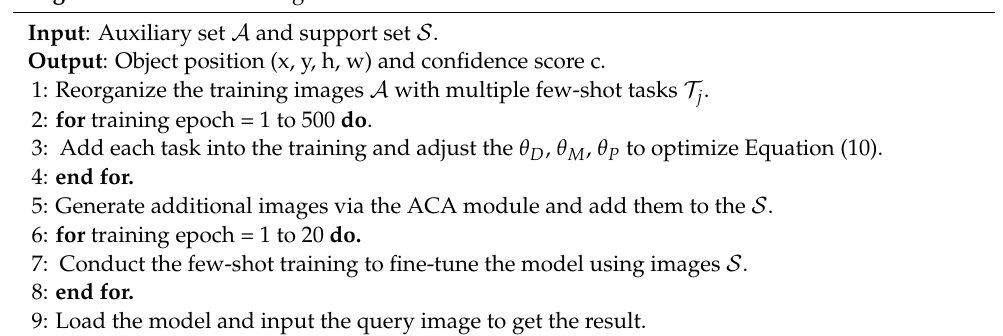
Algorithms 1 Detection Algorithm of the FRW-ACA Model